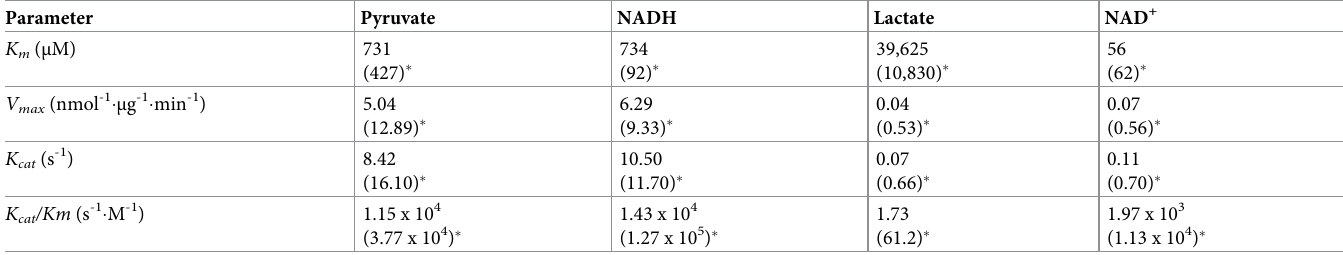
Table 1. CpLDH enzyme kinetics on substrates and co-factors.